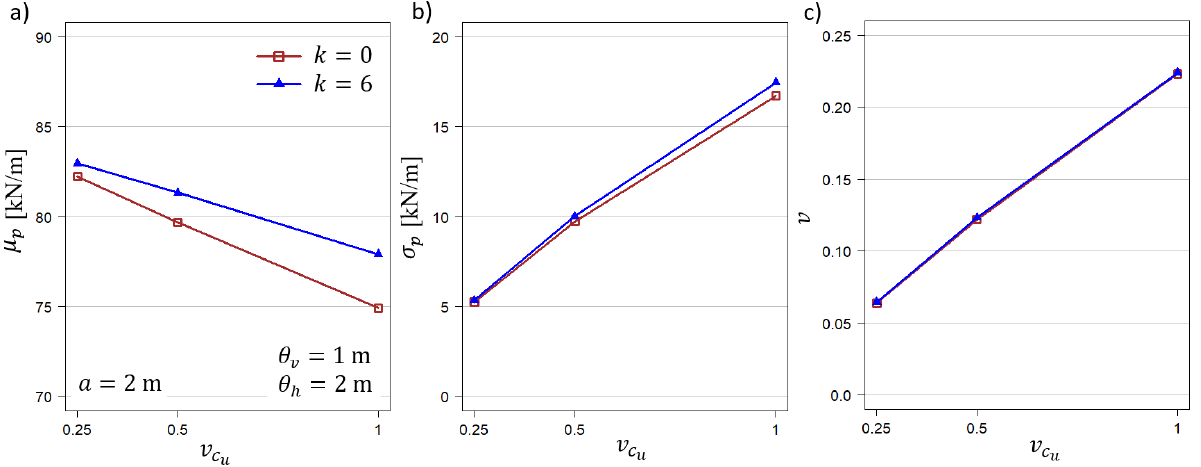
Figure 9: Bearing capacity mean values (a), standard deviations (b), and coefficient of variations (c) as a function of coefficient of variation of undrained shear strength. Two-layered soil considered with homogenous top layer (all parameters not mentioned here are the same as for earlier analyses).